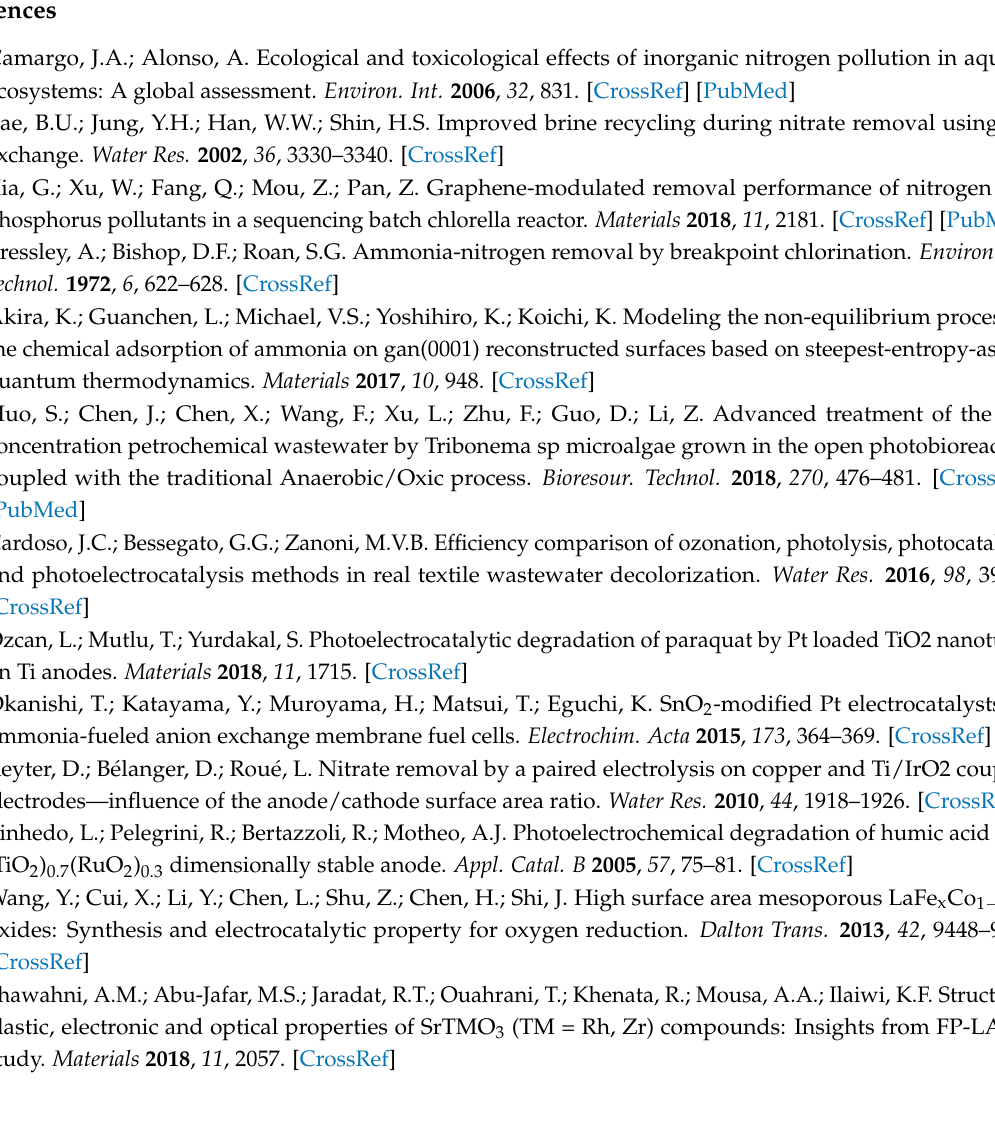
Figure S1: Standard work curve of TN concentration, Figure S2: Effect of amount of SrFe x Ni 1 − x O 3 − δ coated on the anode for the conductivity of ECR, Figure S3: Effect of amount of SrFe x Ni 1 − x O 3 − δ coated on the anode for TN removal ratio, Table S1: UV Absorbances of various TN concentrations for standard work